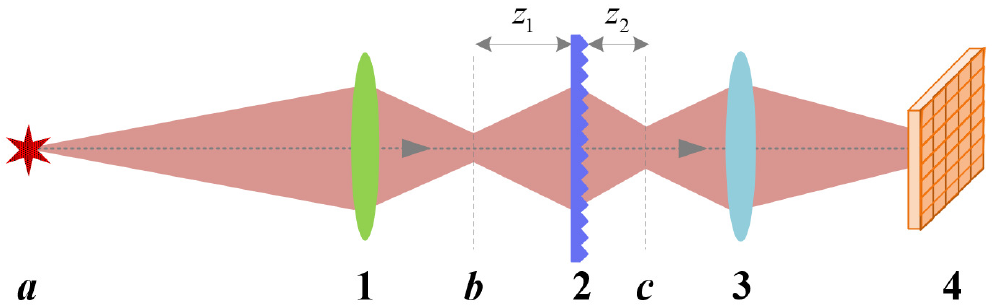
Figure 3. Schematic of the GISC spectral camera: ( a ) the object plane, ( b ) the first image plane, ( c ) the speckles plane, (1) an imaging system, (2) a spatial random phase modulator, (3) a microscope objective, (4) a CCD detector